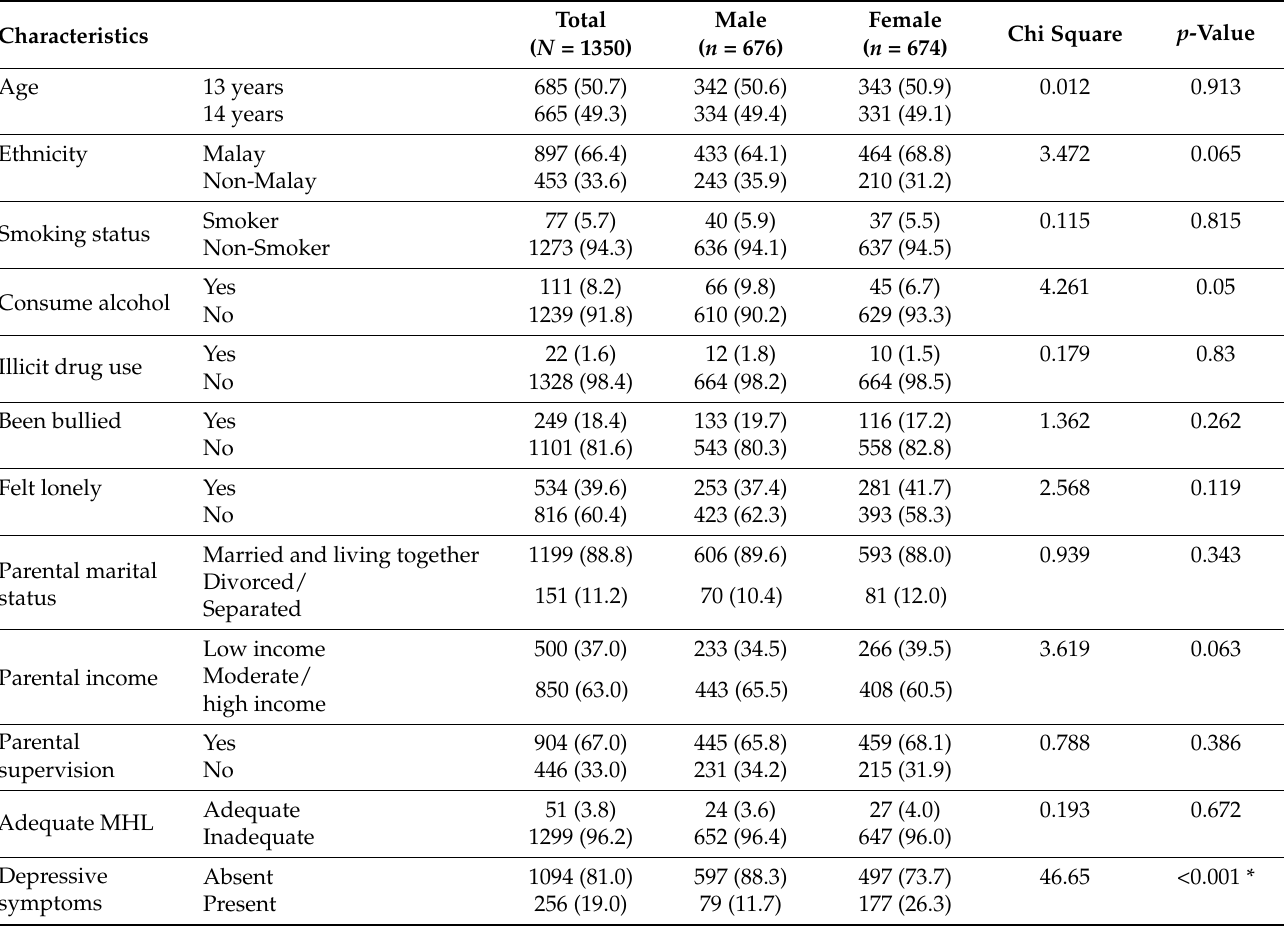
Table 1. Participants